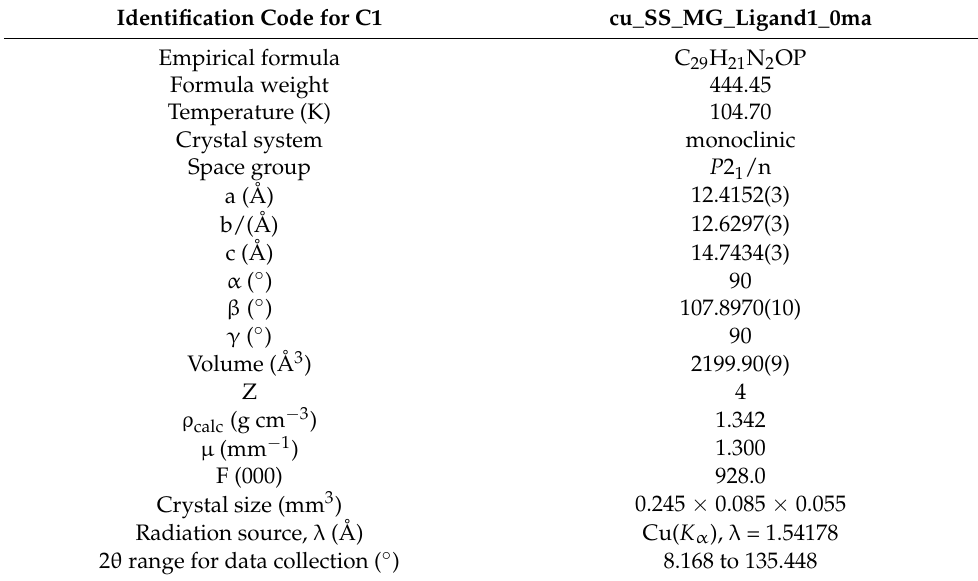
Table 2. Crystal data and structure refinement of L1.